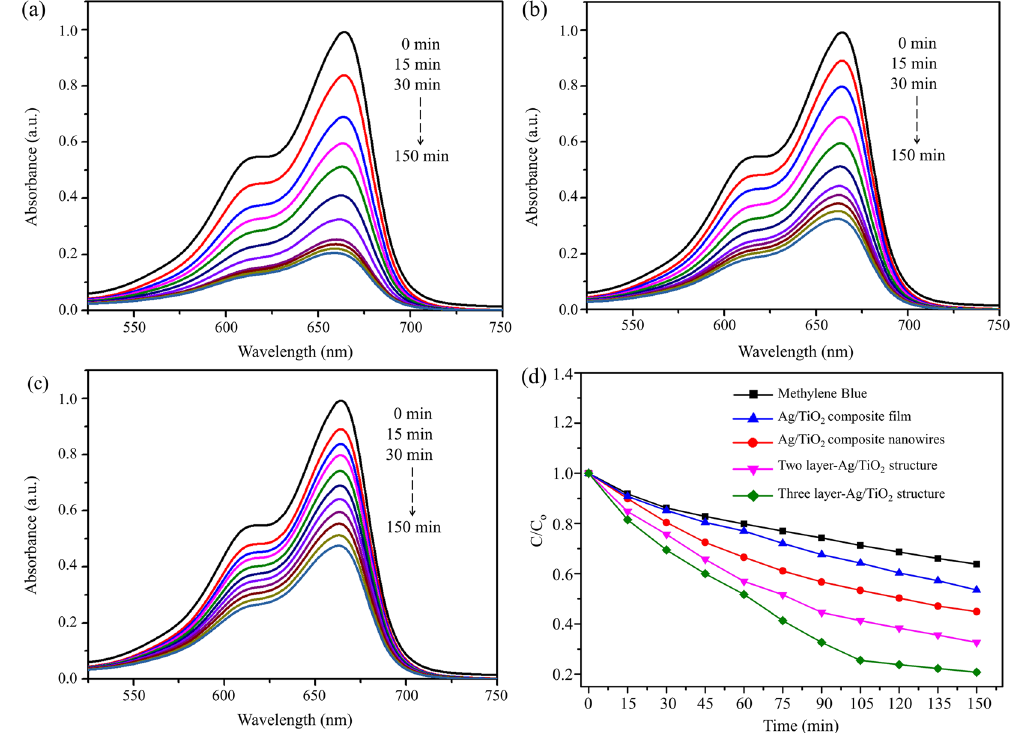
Figure 7. Photocatalytic reaction efficiency of the fabricated samples: ( a ) UV-vis absorbance spectra of MB with three-layer Ag/TiO 2 nanocomposite cross architecture under visible-light irradiation every 15 min. ( b ) UV-vis absorbance spectra of MB with two-layer Ag/TiO 2 nanocomposite cross architecture under visible- light irradiation every 15 min. ( c ) UV-vis absorbance spectra of MB with Ag/TiO 2 nanocomposite wires under visible-light irradiation every 15 min. ( d ) Photocatalytic decomposition of MB solution with and without the fabricated samples under visible-light irradiation every 15 min (Ag/TiO 2 nanocomposite wires, film, and two- and three-layer Ag/TiO 2 nanocomposite cross